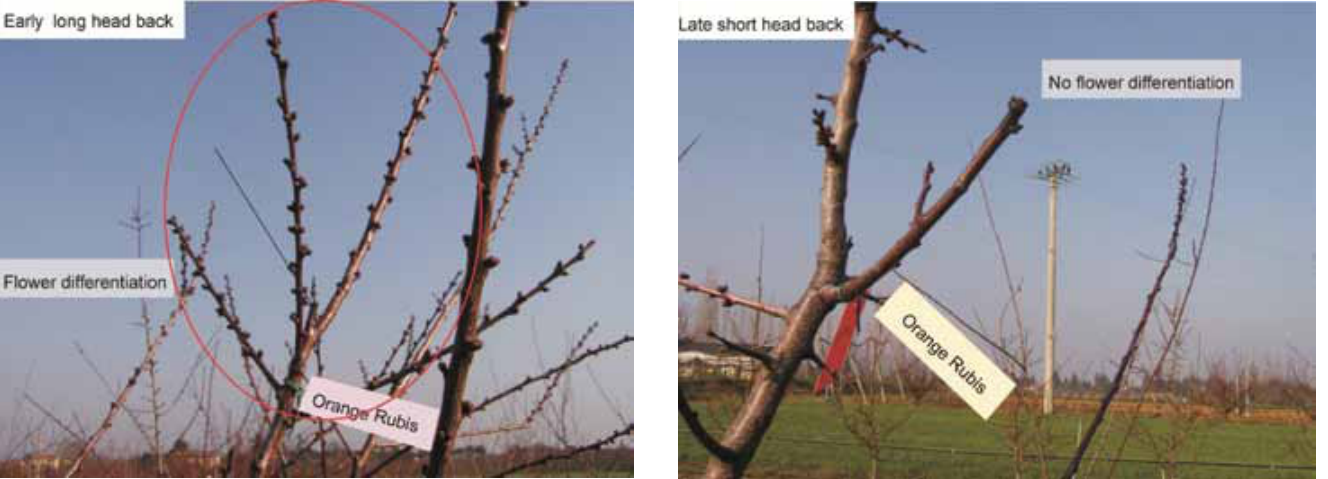
Fig. 5 - Orange Rubis forms shoots after early long-heading back (left): a high number of sylleptic shoot with good flower differentiation is formed. Shoot after late short-heading back (right): sylleptic growth and flower differentiation is